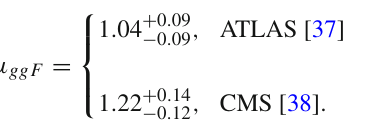
Fig. 3 Radiativecorrection δ m 2 masses, m h , in the TRSM. Inputs as in Fig. 2 2 , h 3